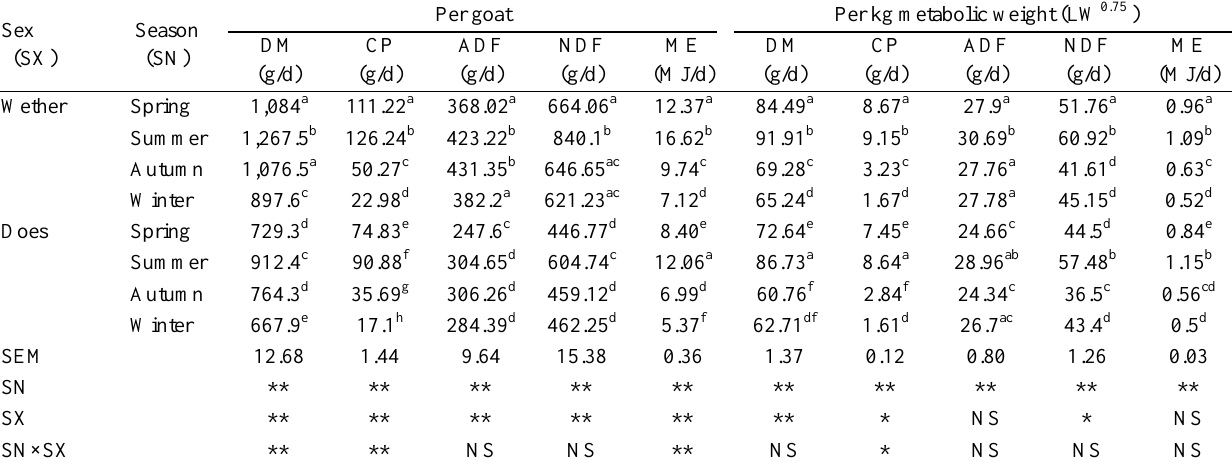
Table 4. Seasonal differences of nutrients intake by wethers and does grazing on introduced L. chinesis pasture Per goat Per kg metabolic weight (LW 0.75 ) Sex Season (SX) (SN) Wether Spring